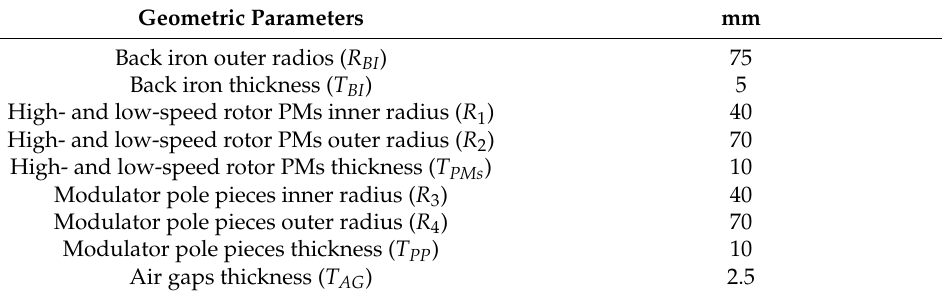
Table 1. Design parameters for the axial-flux magnetic gears. Geometric Parameters mm Back iron outer radios ( R BI ) 75 Back iron thickness ( T BI ) 5 High- and low-speed rotor PMs inner radius ( R 1 ) 40 High- and low-speed rotor PMs outer radius ( R 2 ) 70 High- and low-speed rotor PMs thickness ( T PMs ) 10 Modulator pole pieces inner radius ( R 3 ) 40 Modulator pole pieces outer radius ( R 4 ) 70 Modulator pole pieces thickness ( T PP ) 10 Air gaps thickness ( T AG )